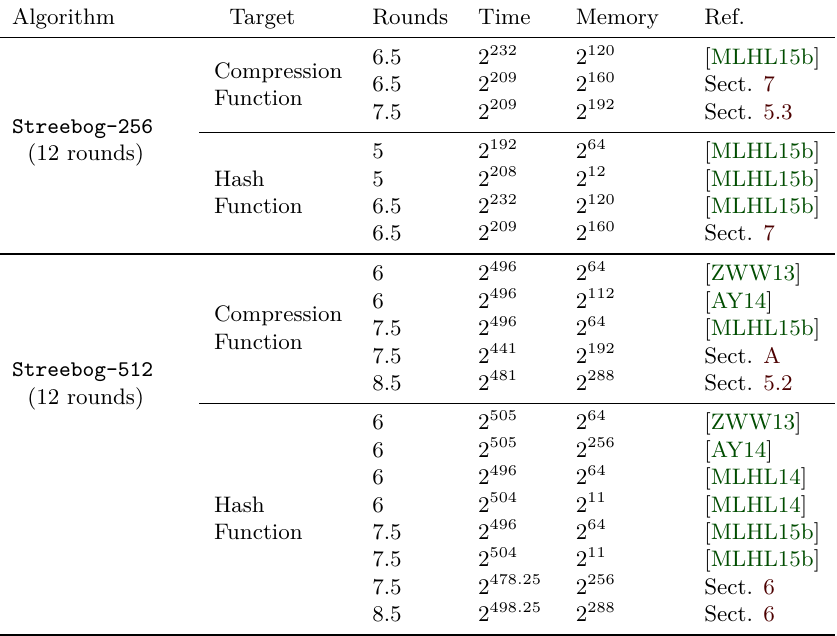
Table 1: Summary of preimage attack results on